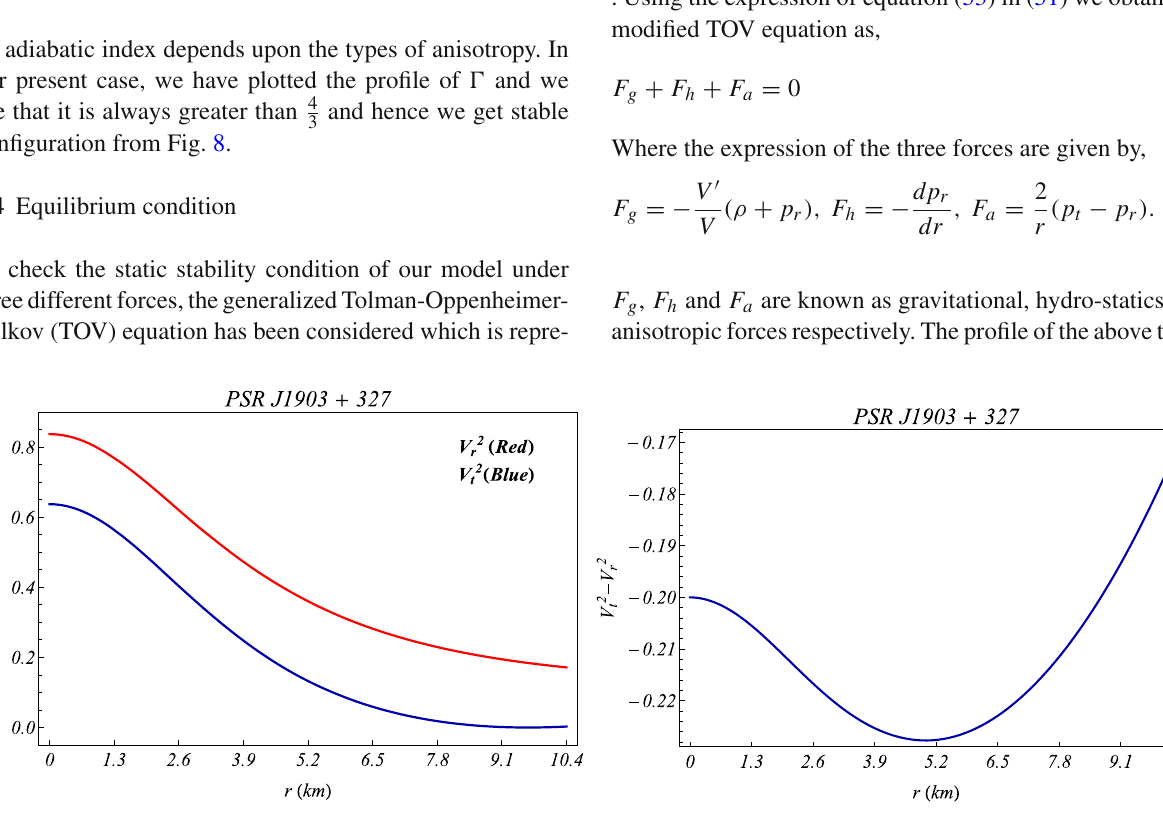
Fig. 7 (Left) The variations of the square of sound velocities ( V 2 r , V 2 t ) and (right) the variation of V 2 t − V 2 r against r are shown inside the stellar interior for the compact star PSR